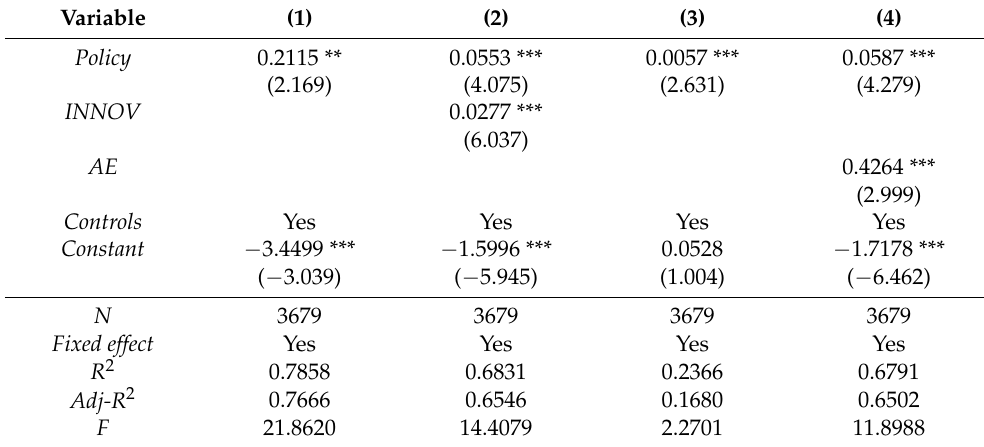
Table 5. Regression results of conduction mechanism